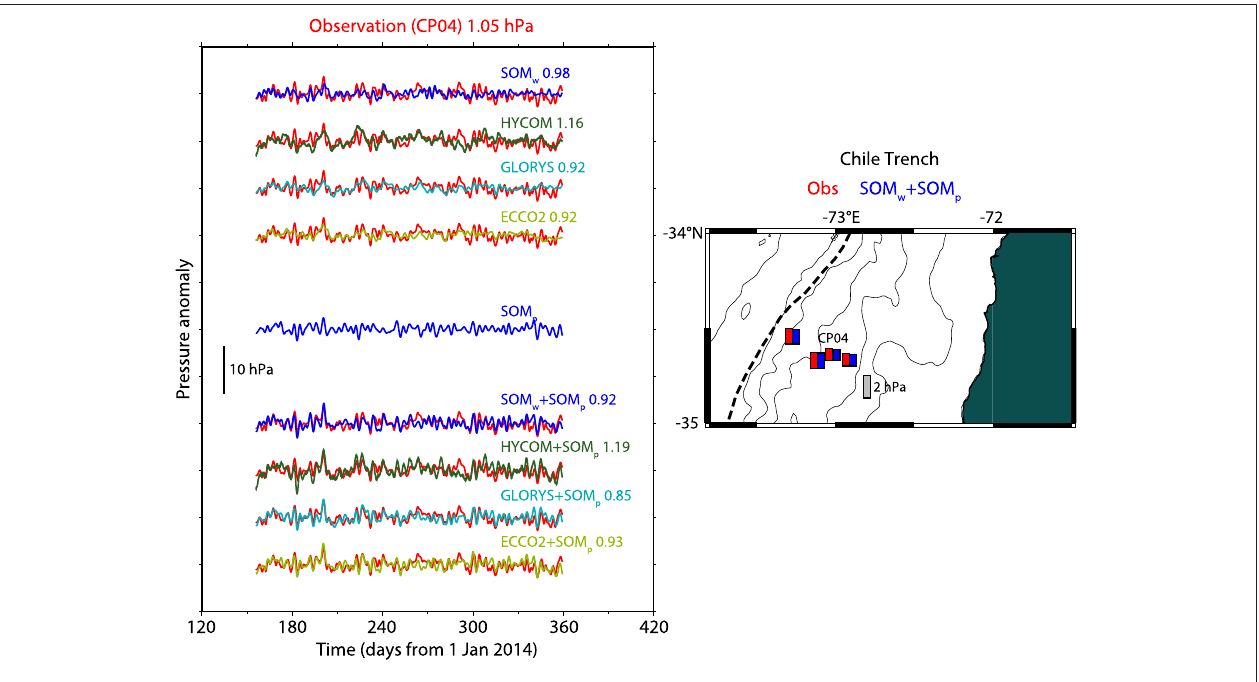
FIGURE 11 | Same as Figure 6 , but for result at CP04 at the Chile Trench.